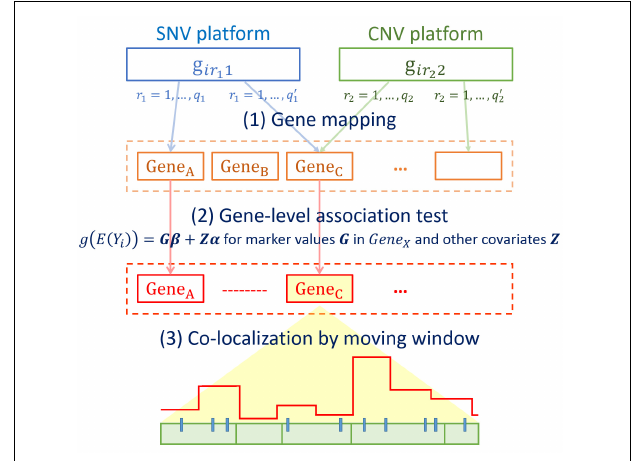
FIGURE 1 | Flowchart of the integrative co-localization (INCO)